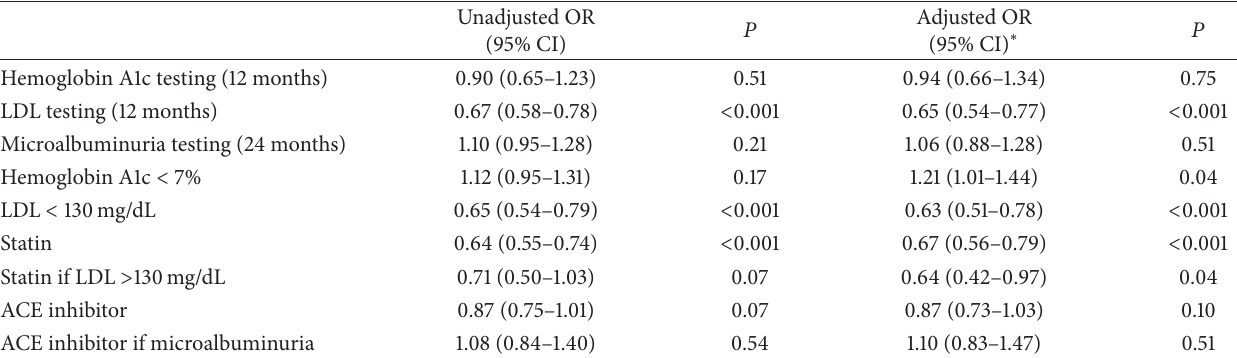
Table 4: Logistic regression models of diabetes process measures for women compared to men amongst subjects with diabetic complications. Unadjusted OR (95%